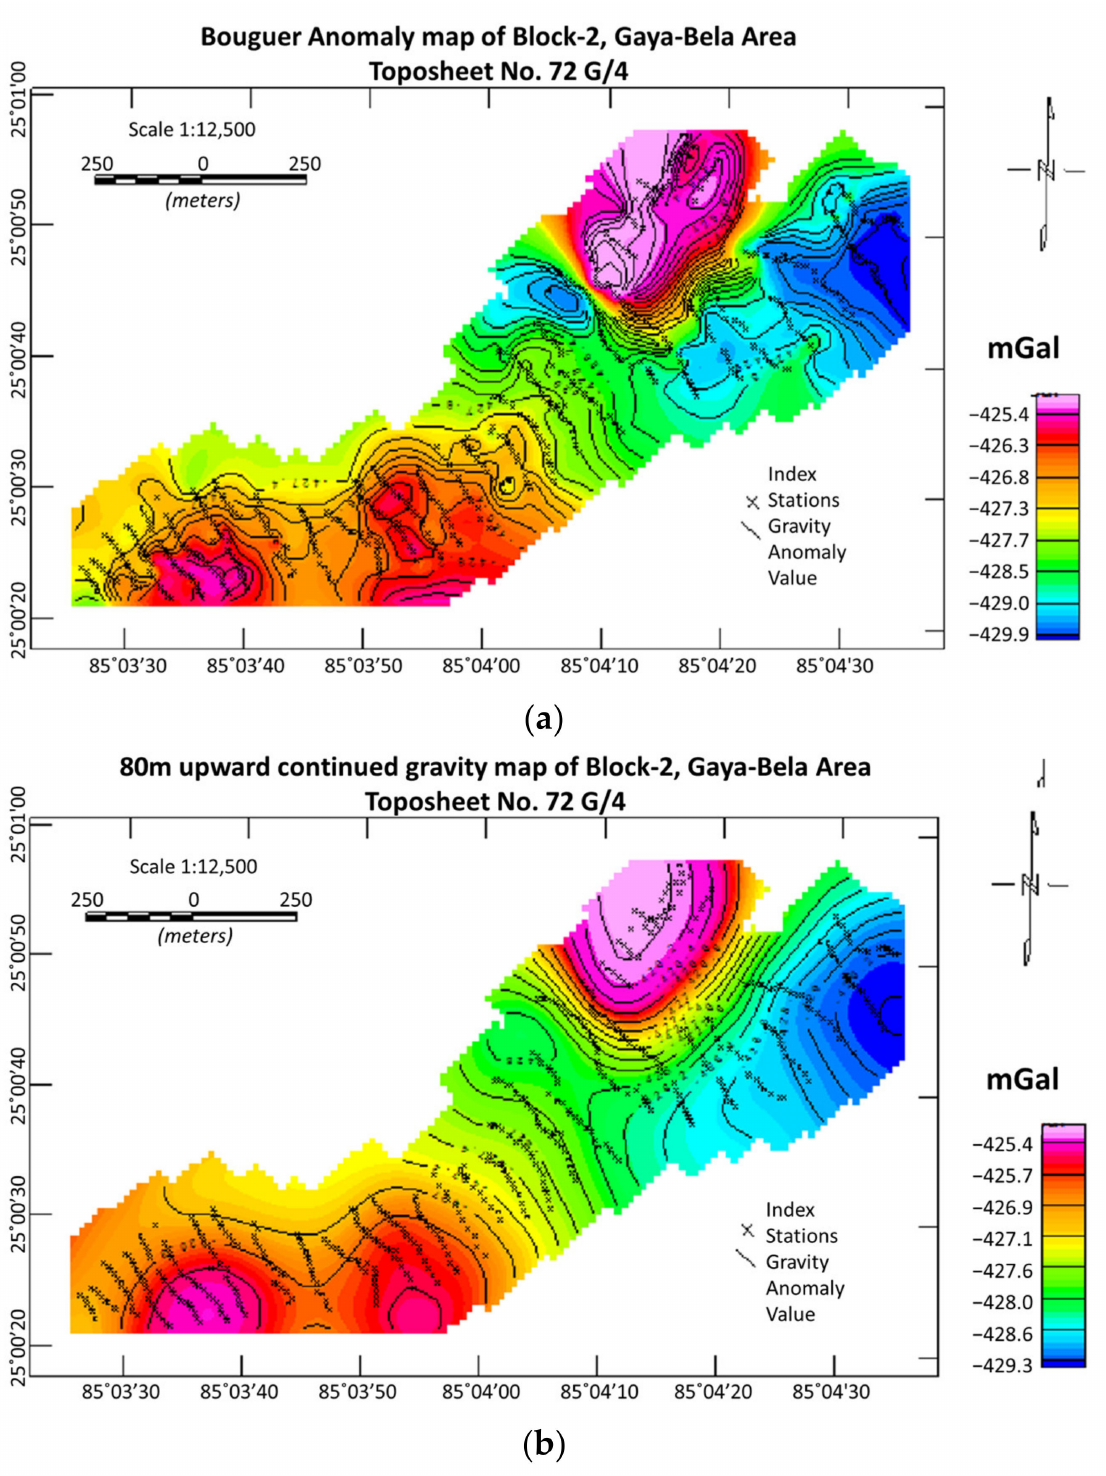
Figure 17. ( a ) Bouguer gravity anomaly map of Block-2, and ( b ) Upward continued Bouguer gravity map of Block-2